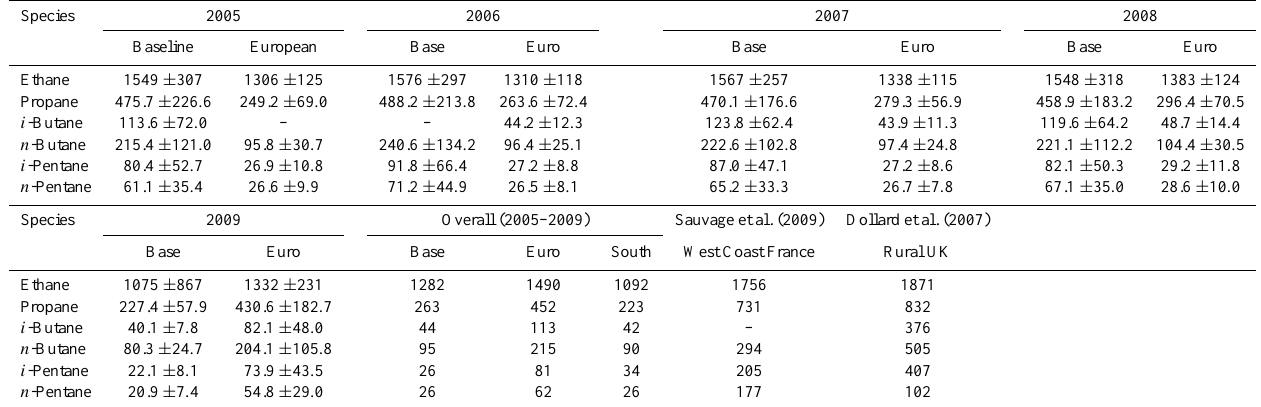
Table 5. Yearly and overall averages of hydrocarbon data (in ppt) split into sectors of baseline air, European and southerly transported air